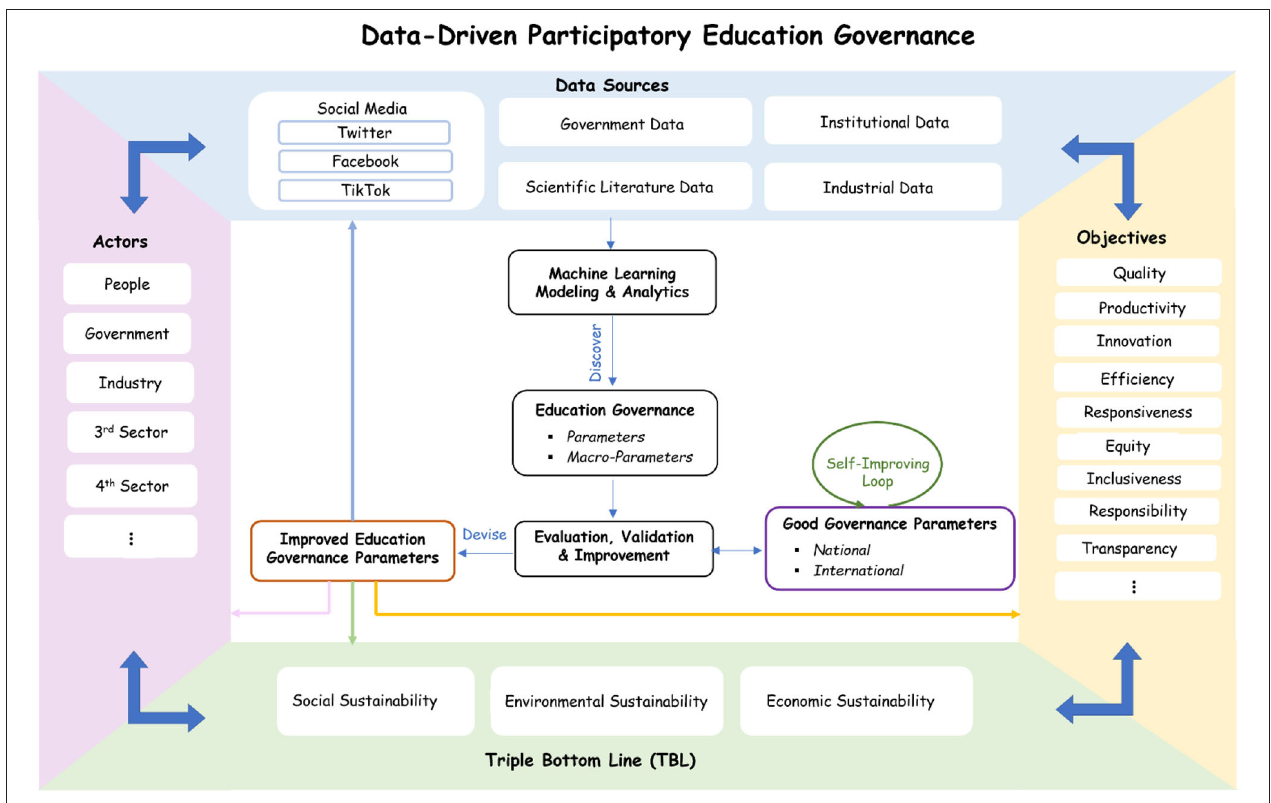
FIGURE 1 | The data-driven education governance